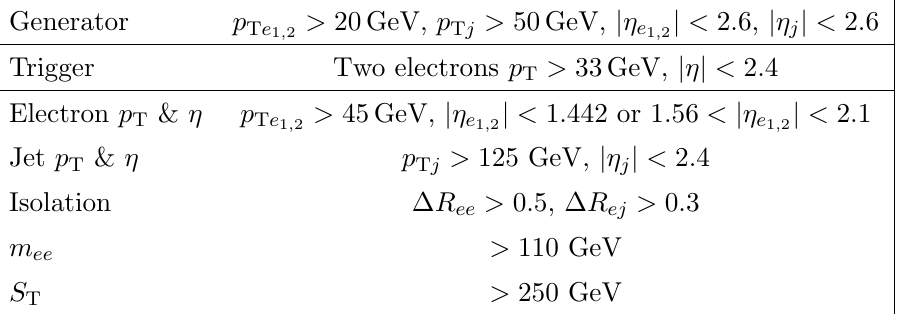
Table 1. Summary of basic cuts for CMS single leptoquark production eej search [17]. Leptons are labeled in order of decreasing transverse-momentum, p T . The full list of selection cuts in [17] can be found in table